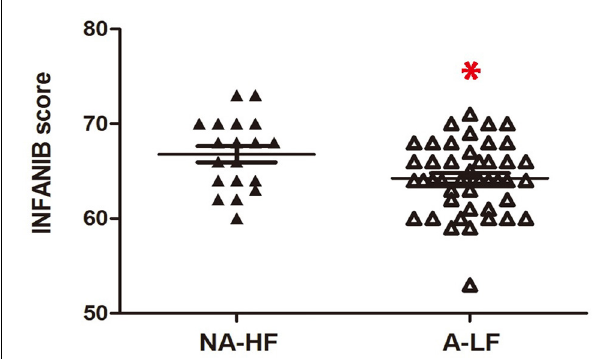
FIGURE 1 | The scores of Infant Neurological International Battery (INFANIB) display a lower value in anemia in the lower ferritin (A-LF) group than non-anemia in the higher ferritin (NA-HF) group at 3 months old. ∗ p < 0.05.